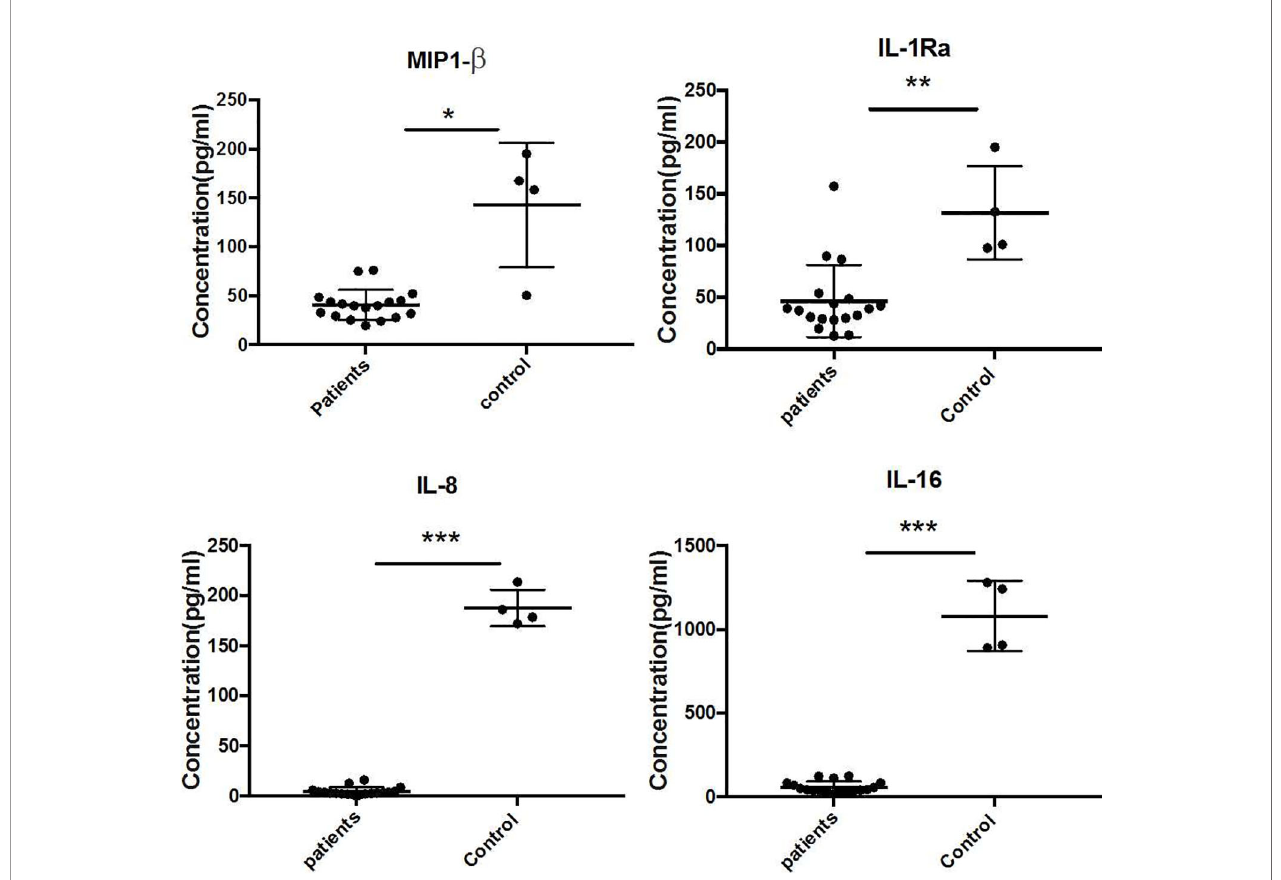
FIGURE 3 | Downregulated expressed cytokines (IL-1Ra, MIP-1 b , IL-8, and IL-16) in CBM patients compared to healthy controls (unpaired t -test, p < 0.05). *P ≤ 0.05, **P ≤ 0.01, ***P ≤